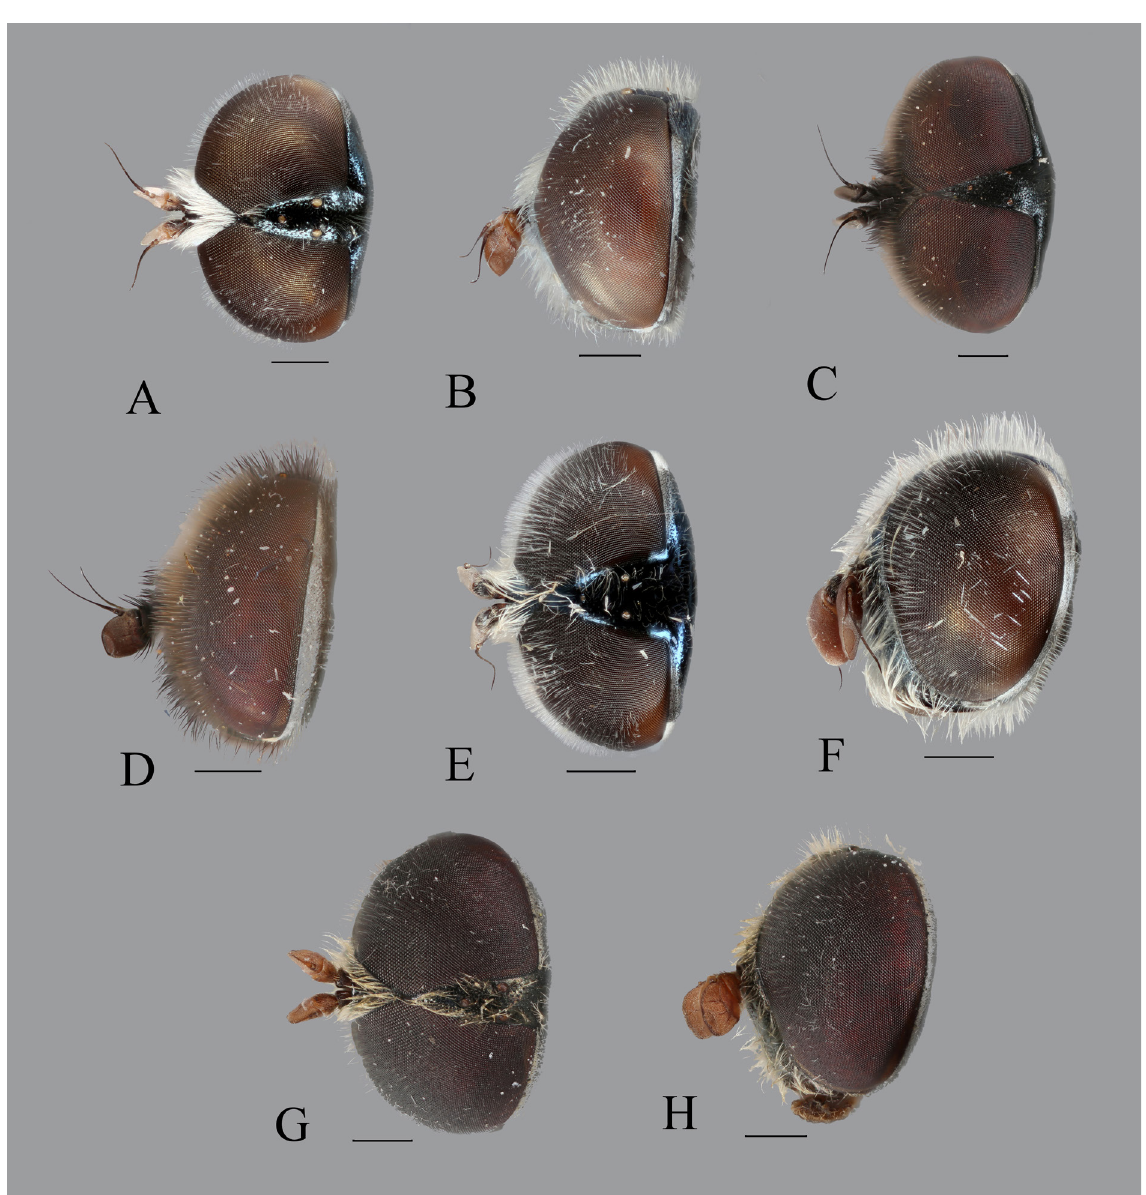
Fig. 16. Head, ♂, dorsal view (A, C, E, G) and lateral view (B, D, F, H). A–B . Eumerus sp., Khash, Iran (HMIM). C–D . E. hissaricus Stackelberg, 1949, Ghoochan, Iran (HMIM). E–F . E. ovoformus Gilasian & van Steenis sp. nov., holotype (HMIM). G–H . E. persarum Stackelberg, 1961, Yazd, Iran (JSA). Scale bars = 0.5